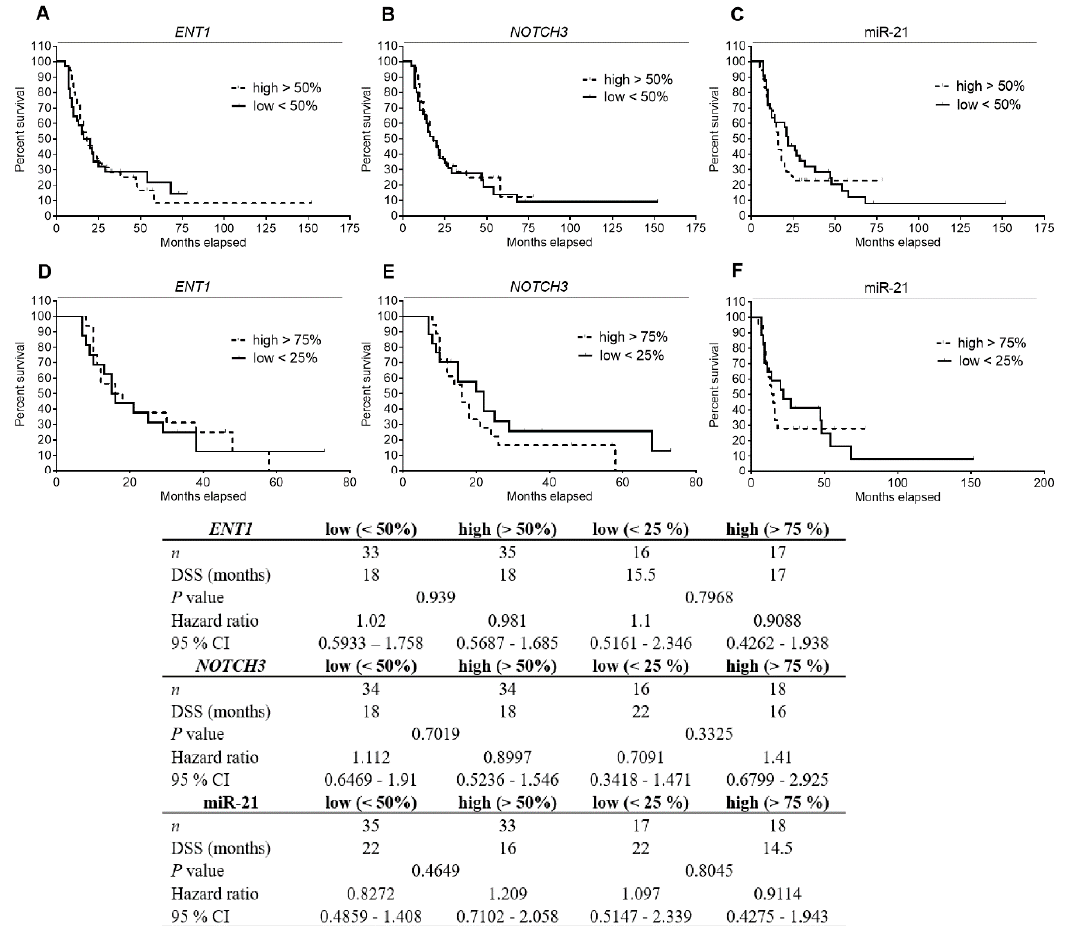
Figure 2. Analysis of patients’ DSS association with ENT1 , NOTCH3 mRNA, and miR-21 levels in PDAC tissue using Kaplan–Meier curves. Patients ( n = 69) were divided into two groups according to the median (low < 50%, high > 50%) ( A – C ) or, alternatively, only subgroups of patients belonging to the first and fourth quartiles (low < 25%, high > 75%) ( D – F ) of expression of ENT1 ( A , D ), NOTCH3 ( B , E ), or miR-21 ( C , F ) were selected. No significant differences between the tested subgroups of patients were observed. Statistical significance was evaluated by applying log-rank test analysis.